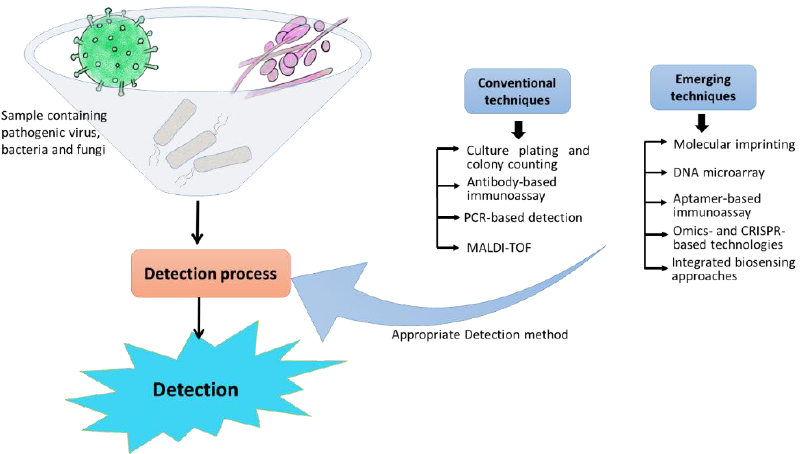
Scheme 1. Schematic representation of conventional and emerging techniques for pathogen